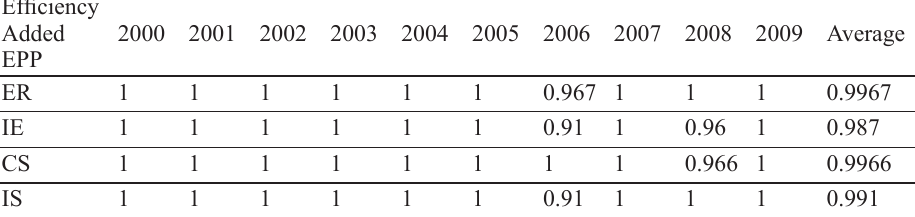
Table 4. The results of adding one input to DEA with ME as non discretionary and TA and PTE as discretionary inputs